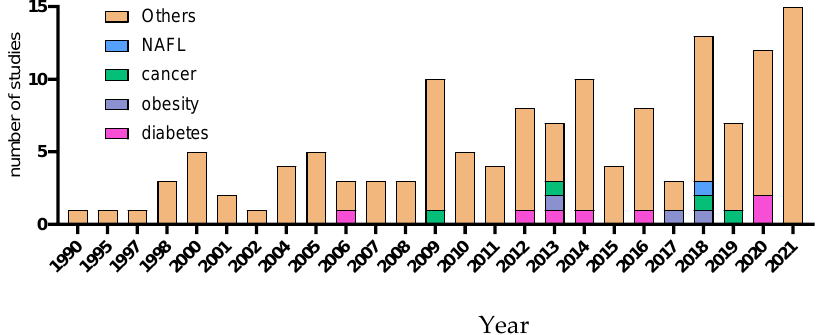
Figure 3. Frequency of published studies on alkaline reduced water by subcategories of metabolic syndrome. Journal articles that contain terms related to ARW and metabolic syndrome were indexed from Scopus. Abbreviation: non-alcoholic fatty liver, NAFL .